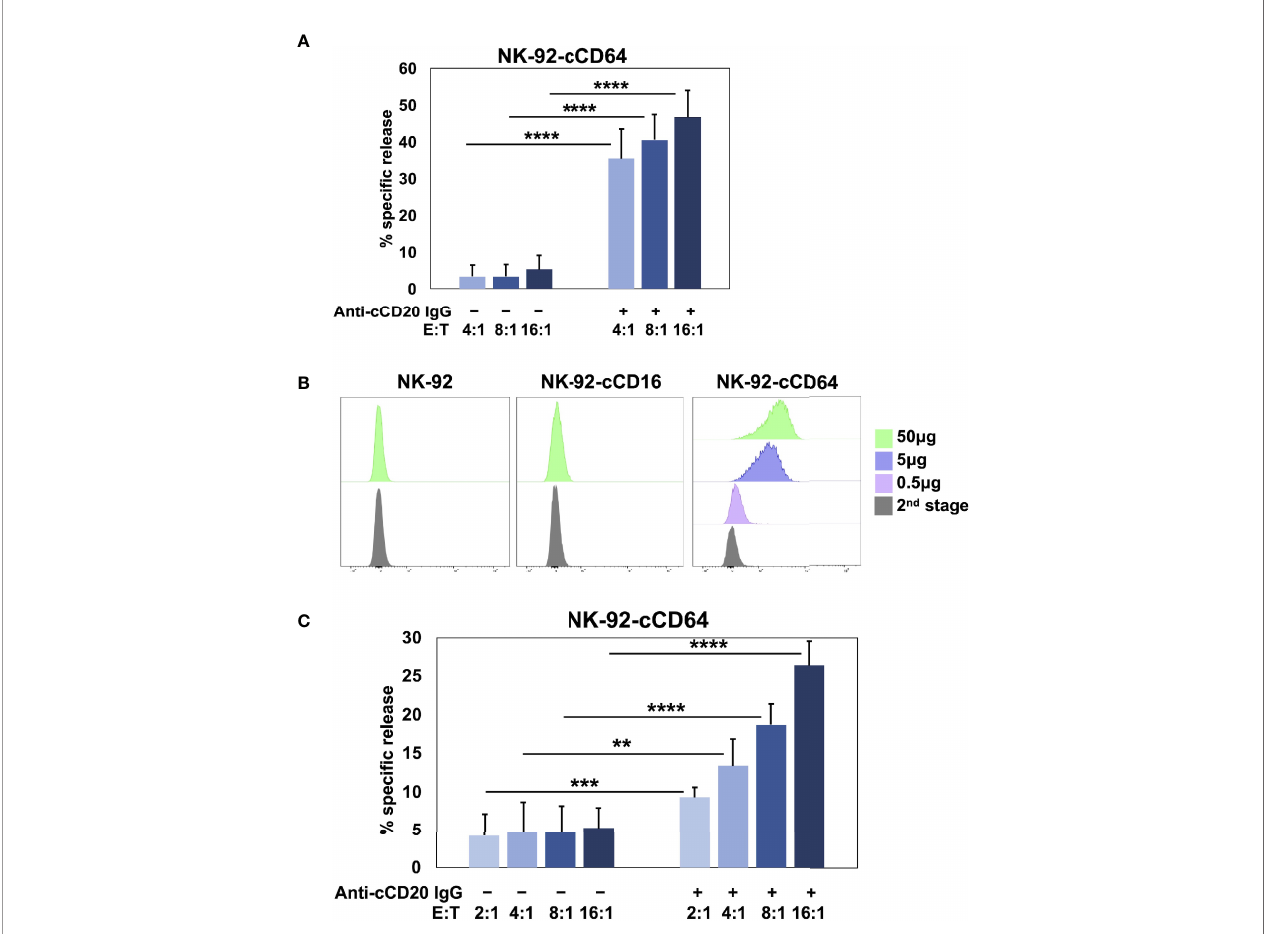
FIGURE 5 | NK-92 cells expressing canine CD64 mediate ADCC when armed with a tumor-targeting mAb. (A) NK-92 canine CD64 (cCD64) cells were incubated with SKOV-3 canine CD20 cells at the indicated E:T ratios in the presence or absence of a caninized anti-canine CD20 mAb for 2 h at 37°C. Data are represented as % speci fi c release and the mean ± SD of 3 independent experiments is shown. Statistical signi fi cance is indicated as ****p < 0.0001. (B) NK-92-cCD16A and NK- 92-cCD64 cells were incubated with or without biotinylated canine IgG at various concentrations for 1 h at 37°C, washed, stained with fl uorophore-conjugated streptavidin, and analyzed by fl ow cytometry. Data are representative of at least 3 independent experiments. (C) NK-92 canine CD64 cells were incubated in the presence or absence of caninized anti-canine CD20 mAb (5 m g/ml), washed, and exposed to SKOV-3 canine CD20 cells at the indicated E:T ratios for 2 h at 37°C. Data are represented as % speci fi c release and the mean ± SD of 3 independent experiments is shown. Statistical signi fi cance is indicated as **p < 0.01, ***p < 0.001, ****p <